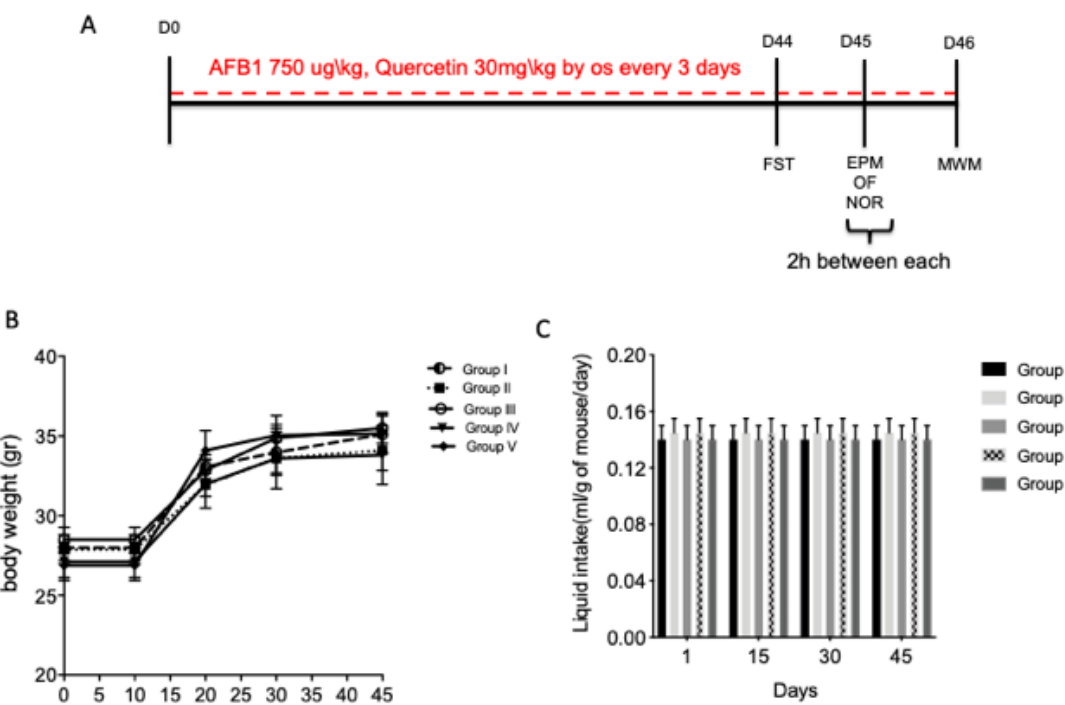
Figure 1. Experimental time line ( A ); ( B and C ). E ff ect of quercetin on body weight and liquid intake on aflatoxin B1 (AFB1) mice. Group I (control); Group II (veh + control); Group III (quercetin-only); Group IV (AFB1); Group V (afb1 + quercetin). Forced swimming test (FST), elevated plus maze (EPM), open-field (OF), novel object recognition (NOR) and Morris water maze (MWM). The behavioral tests were conducted on different days: FST after 44 days of first treatment; EPM, OF and NOR were conducted on day 45 in the same day, three hours between each test; MWM was conducted on day 46 of the experiment.